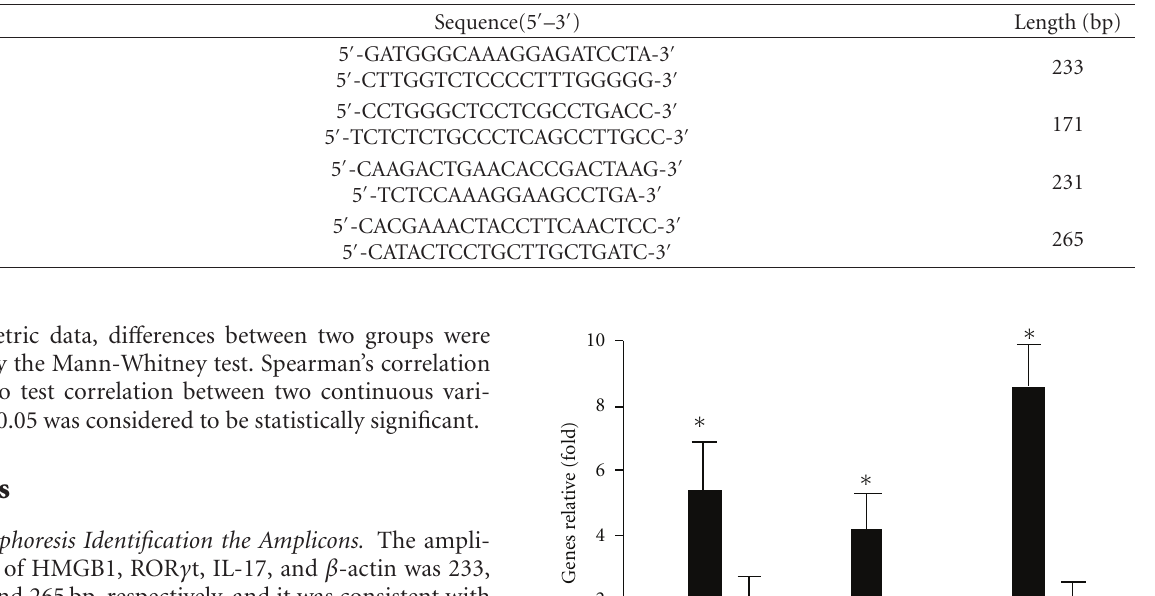
Table 1: The primers used in this study.